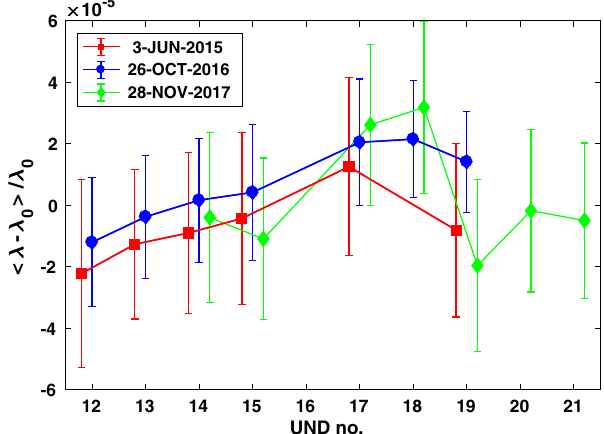
FIG. 6. Relative mean wavelength normalized to the nominal central value as a function of effective undulator # for the 1.0 keV experimental shifts. The error bars correspond to the RMS deviations of the individual shot values from the mean undulator. To improve error bar legibility, the curves have been slightly offset both horizontally and vertically from each